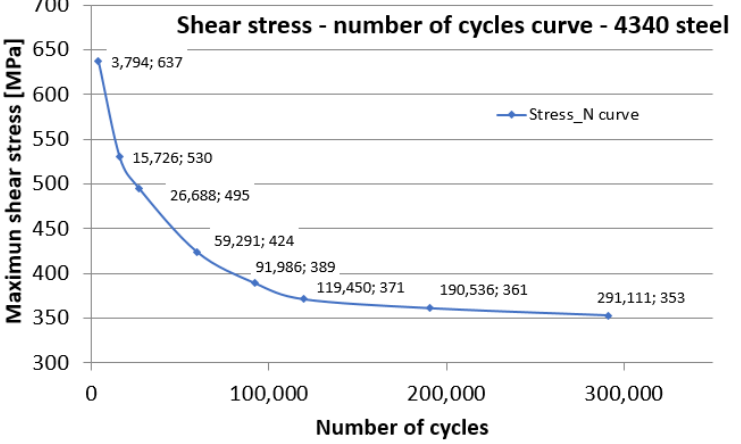
Figure 10. τ -N fatigue durability curve for 4340 steel.